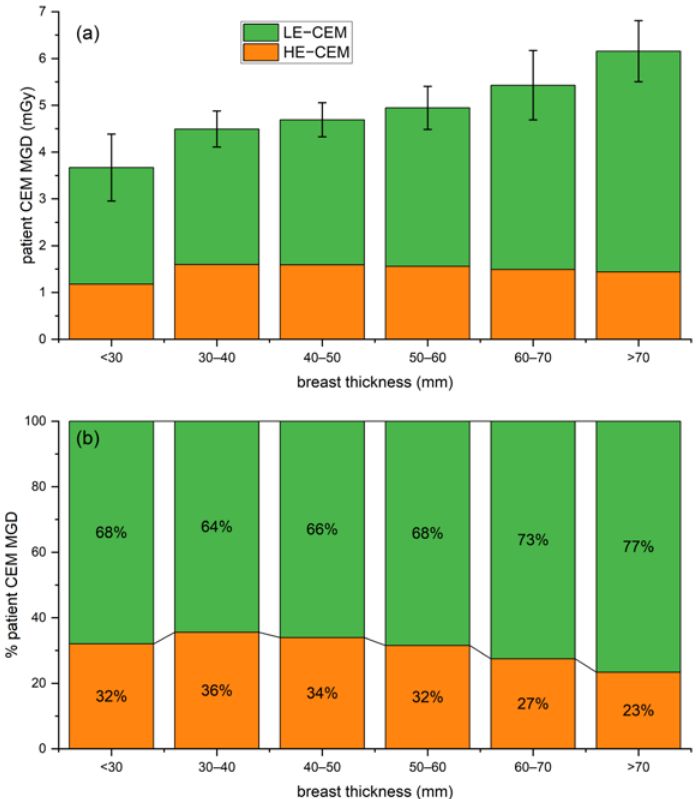
Figure 6. ( a ) Stacked column plot of overall patient MGD associated with CEM (LE in orange and HE in green) for increasing breast thickness ranges. ( b ) Normalized stacked plot showing the percentage of patient dose due to LE and HE images for increasing breast thickness ranges.